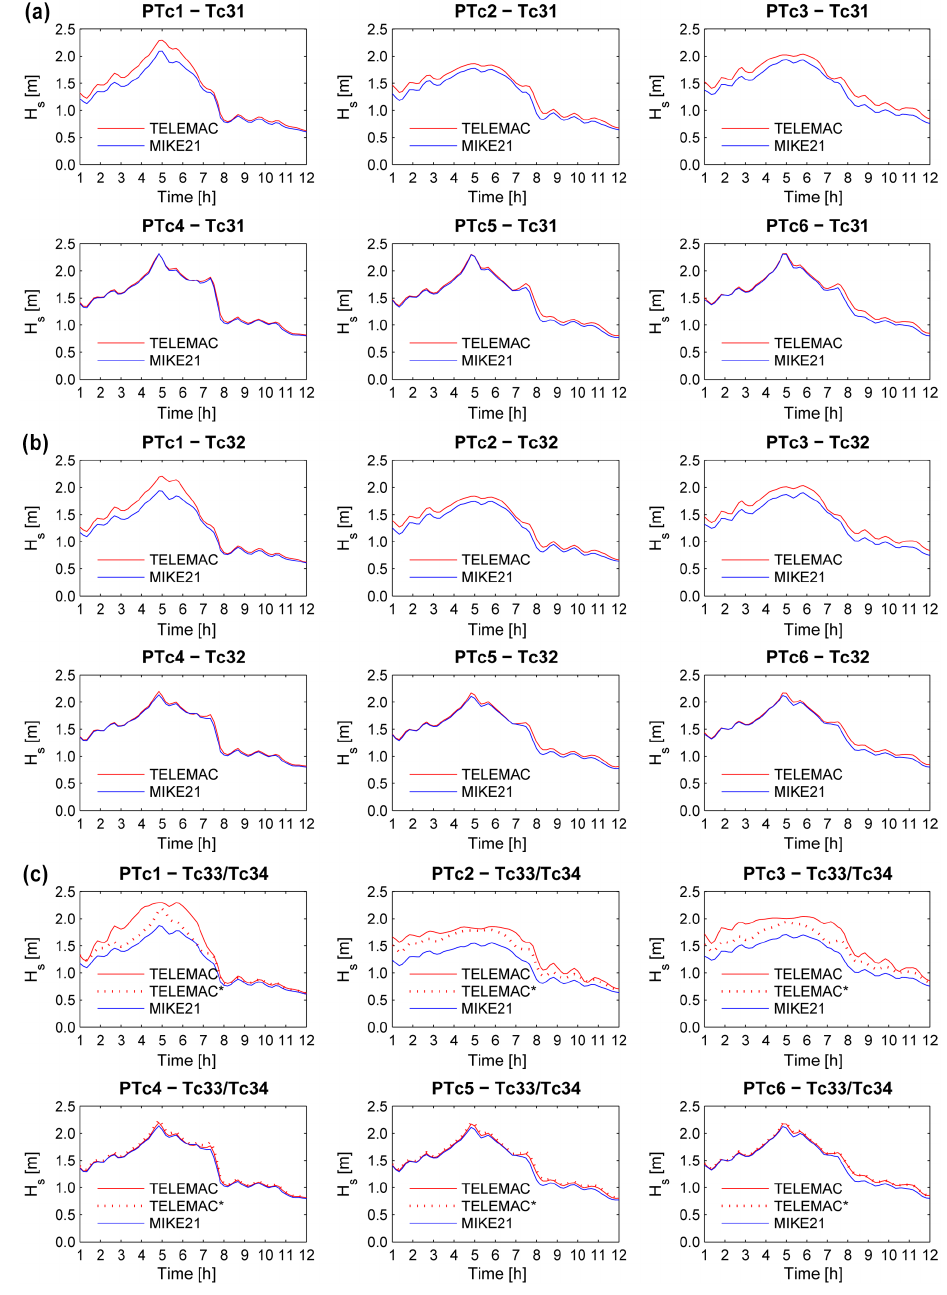
Figure 9. Comparison of TELEMAC and MIKE21 results ( H s ) at points within (PTc1, PTc2, PTc3) and outside of the breaker zone (PTc4, PTc5, PTc6) for the Brindisi–Torre Guaceto case study for runs (a) Tc31, (b) Tc32 and (c) Tc33/Tc34 ∗